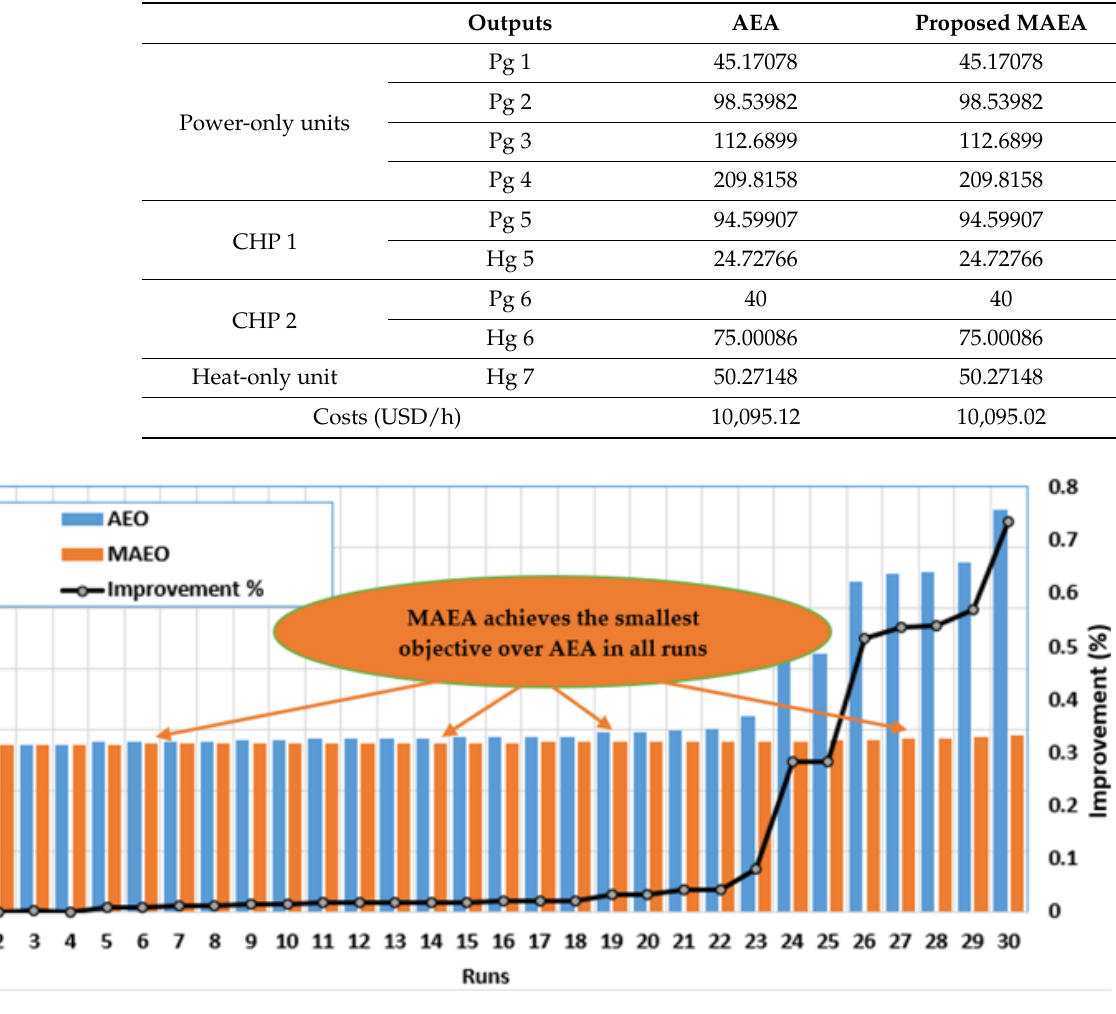
Figure 7. Obtained costs for all simulated runs of the proposed MAEA and the basic AEA of Case 2. Table 4. Robustness metrics of the proposed MAEA and the basic AEA of Case